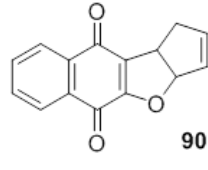
– Structure of IVS320.